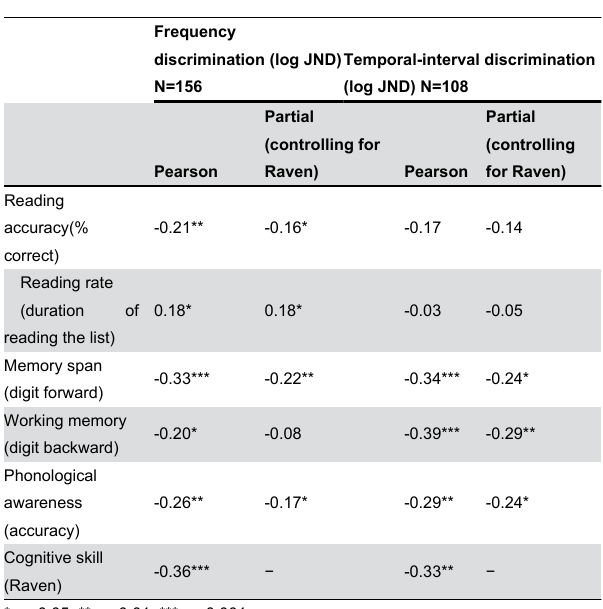
Table 1. Correlations between auditory discrimination, cognitive and literacy related